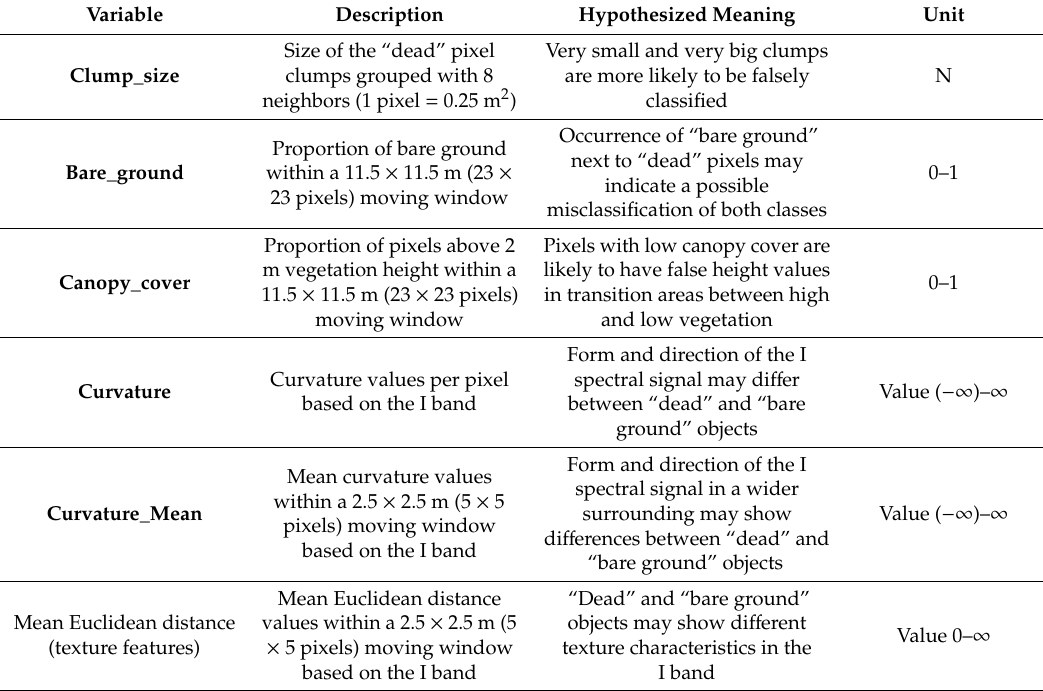
Table 3. Predictor variables tested for the deadwood-uncertainty model with their description, hypothesized meaning and unit. Variables selected for the final model are presented in bold. I: infrared spectral